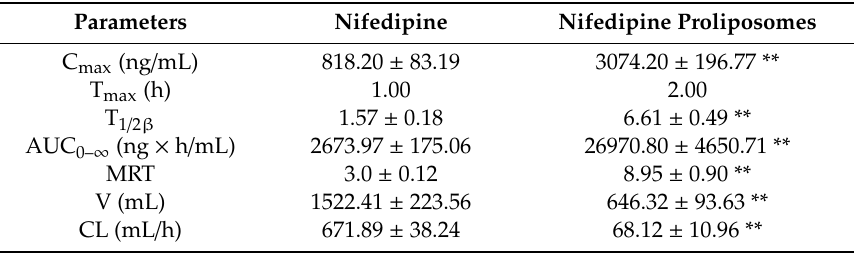
Table 5. Pharmacokinetic parameters of nifedipine in rats following an oral of nifedipine or nifedipine proliposomes, respectively (mean ± SD, n =